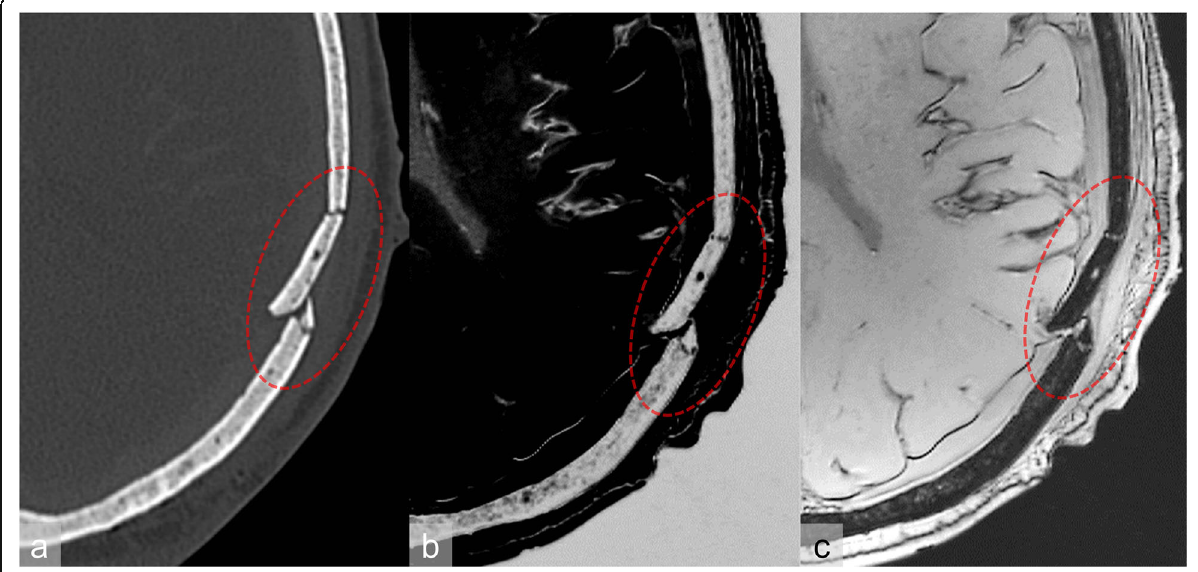
Fig. 1 Case 1. Computed tomography ( a ) and 7-T magnetic resonance imaging ( b : spoiled gradient-echo sequence, contrast inverted; c : spoiled gradient-echo sequence) demonstrate a fracture (red circle) of the left parietal bone. The fracture was very well delineated thanks to the high spatial resolution of the 7-T spoiled gradient-echo